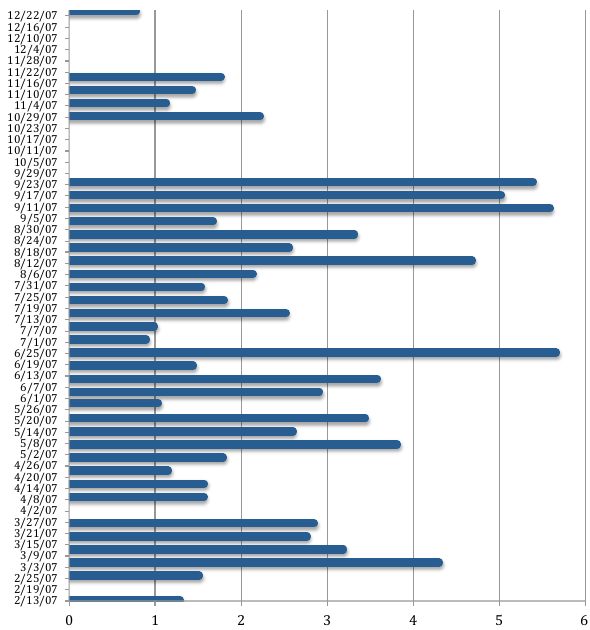
Fig. 3. p,p’ -DDE/p, p 0 -DDT ratios (x-axis) for weekly atmospheric samples (y-axis: sampling start date) from the Troll station (Antarc- tica); x-axis = conc./conc., y-axis: starting date (sampling year